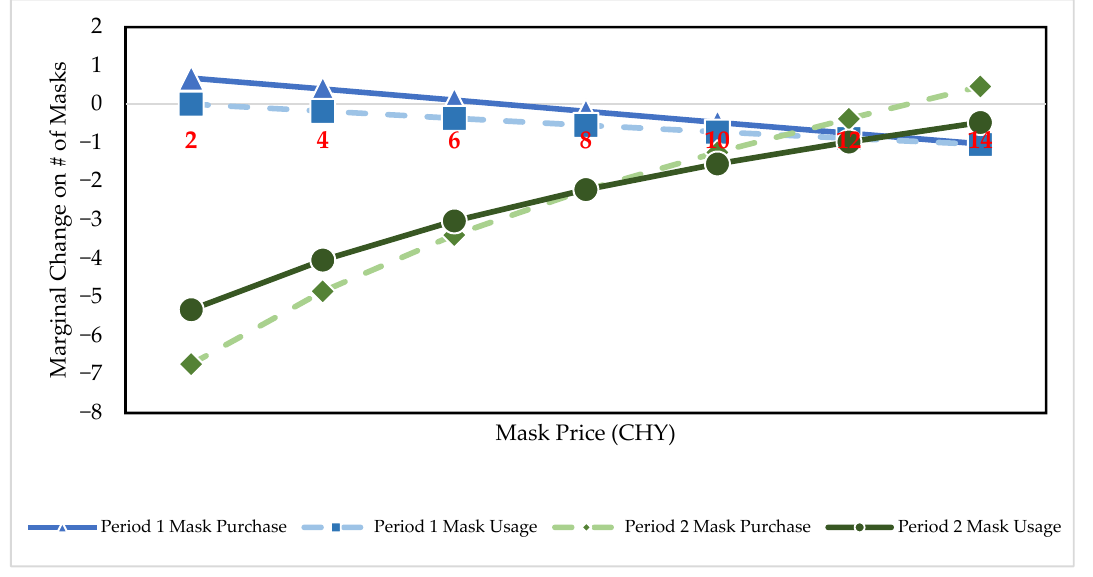
Figure 4. The unconditional marginal effects on number of purchased and used masks due to price change.